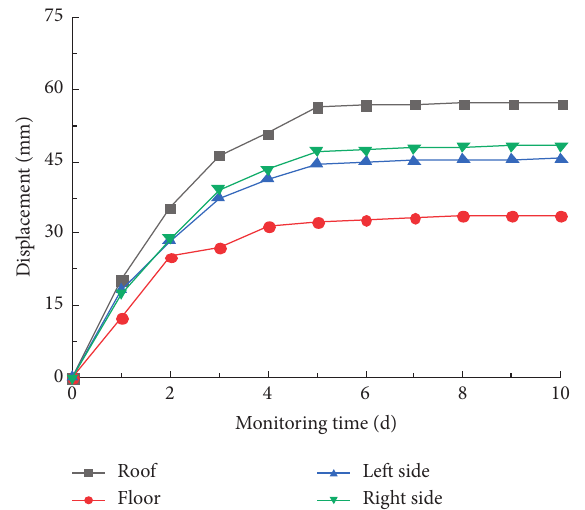
Figure 13: Monitoring curves of surrounding rock displacement of roadway under the new support scheme.